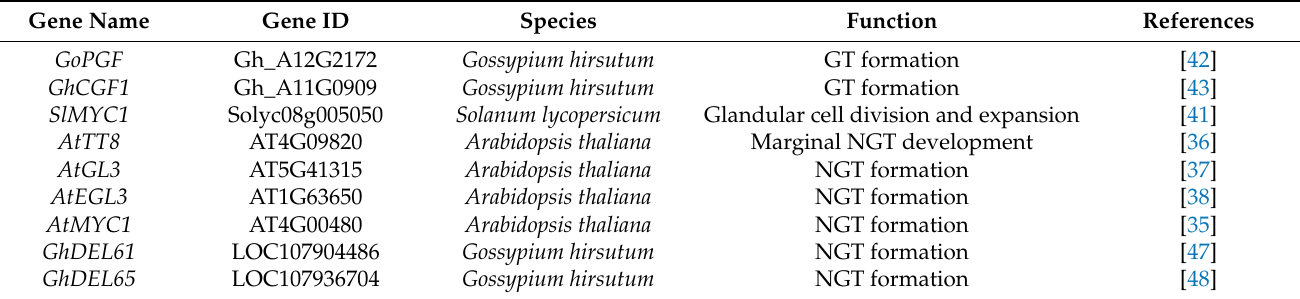
Table 2. Detailed information about MYC genes involved in plant trichome